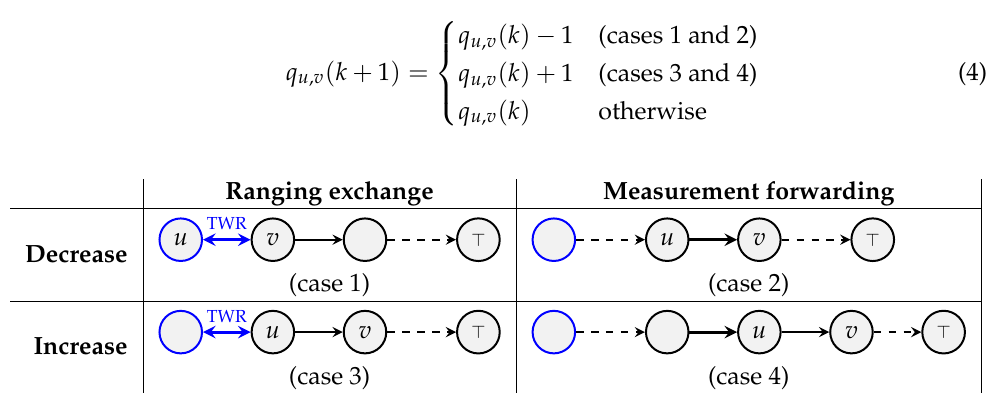
Figure 10. Evolution of queue depth from q u , v ( k ) to q u , v ( k + 1 ) during timeslot k . The communication that occurs during timeslot k is shown with a very thick edge. Blue nodes are reserved tags and blue edges are ranging exchanges.